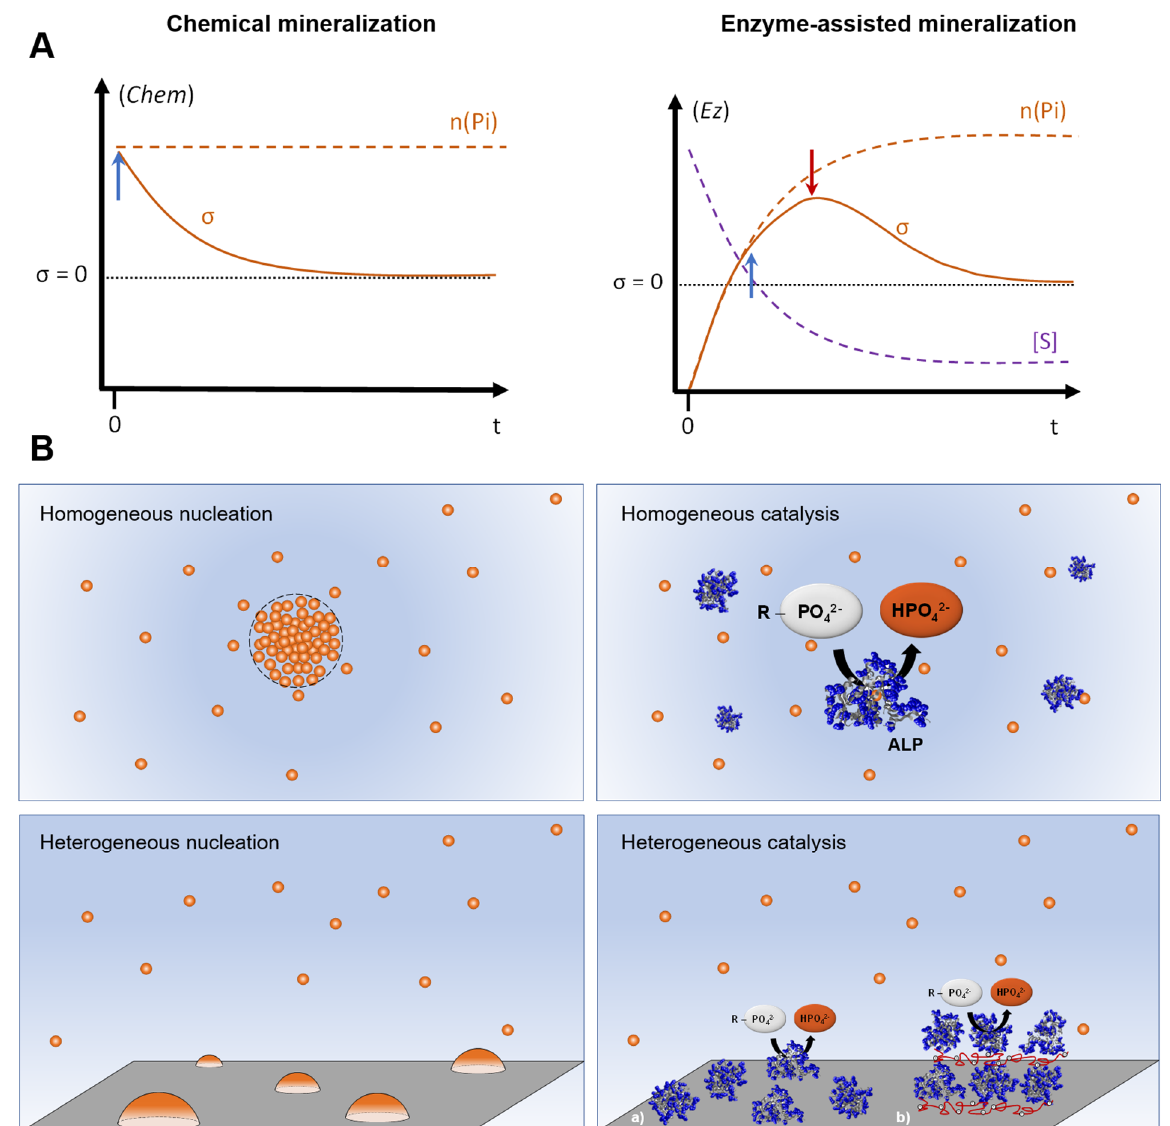
Figure 4. ( A ) Representation of examples of the schematic evolution with time of the supersaturation σ in the presence of an excess of Ca 2+ ions in the case of (left, Chem ) chemical mineralization without enzymes or (right, Ez ) enzyme-assisted mineralization. In the left panel, the phosphate ions (Pi) are generated through the consumption of substrate molecules (S). n(Pi) is the total quantity of Pi introduced in the solution. The blue arrows pointing up ( ↑ ) indicate the beginning of the mineralization process (at t = 0 for the case without enzyme), and the red arrow pointing down ( ↓ ) represents the moment where the Pi generation through the enzymatic process becomes slower than the Pi consumption due to the mineralization. ( B ) A simplified view depicting (left) chemical vs (right) enzyme-assisted mineralization and the different modes of CaP nucleation. (left, top): Formation of a nucleus from supersaturated solution through a dynamic and stochas- tic association of ion precursors (spheres), which then grows to mature bulk phase (adapted from [127]). (left, bottom): Heterogeneous nucleation of CaP mineral (hemispherical particles) driven by the surface energy of the support. (Right, top): Enzyme-assisted mineralization through homogeneous catalysis, where the enzyme (ALP) is present in the same phase as its substrate, ester phosphate and CaP ion precursors. (Right, bottom): Heterogeneous catalysis through immo- bilized enzymes on the support. Immobilization can be achieved by (a) appropriate surface functionalization that favors the interaction with enzyme (physical adsorption or covalent bonds) or (b) by using the sequential layer-by-layer assembly to embed a high number of enzymes and other biomacromolecules of interest. The multilayered film may then serve as a miniaturized bioreactor for mineralization.